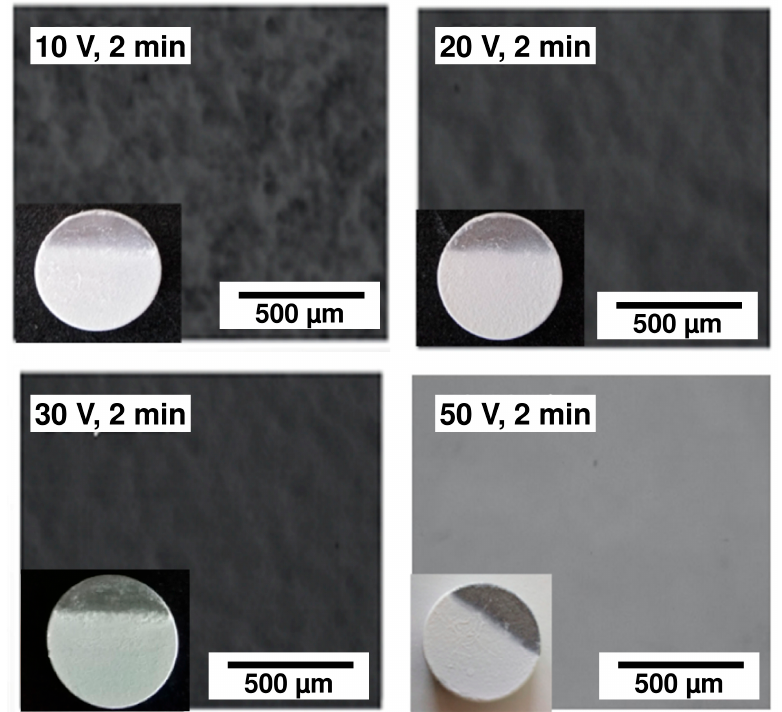
Figure 9. Optical micrographs of the 45S5 Bioglass ® coatings obtained by electrophoretic deposition (EPD) for 2 min at 10, 20, 30 and 50 V. Table 3. Thickness values of the two optimal 45S5 Bioglass ® coatings.